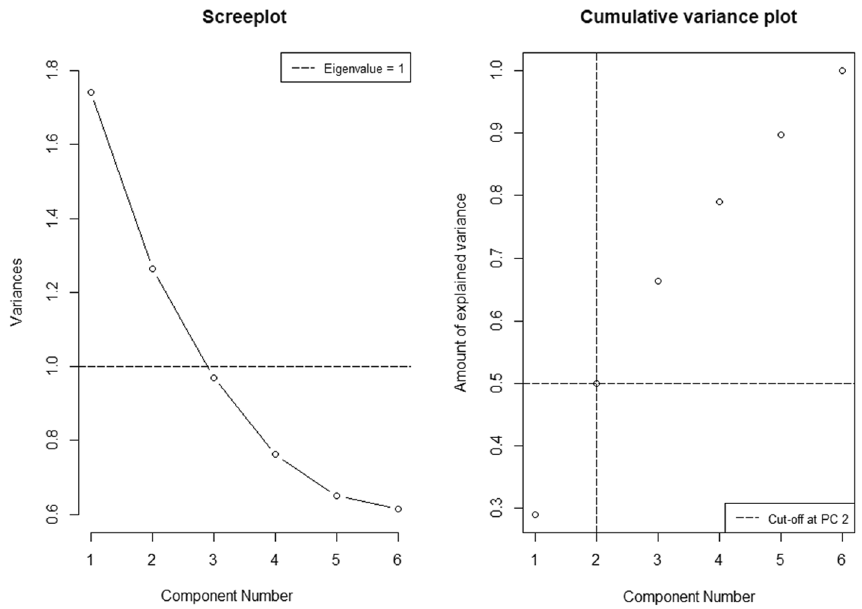
Fig. 1 Screenplot and cumulative variance plot from principal component analysis of family socio‑economic status